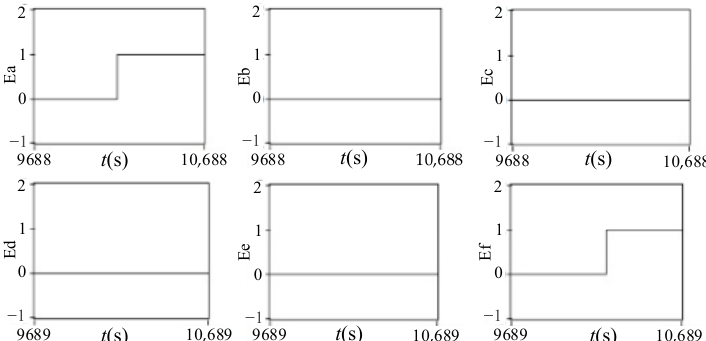
Figure 33. Fault index waveform in the case of phase failure of phase a and phase f